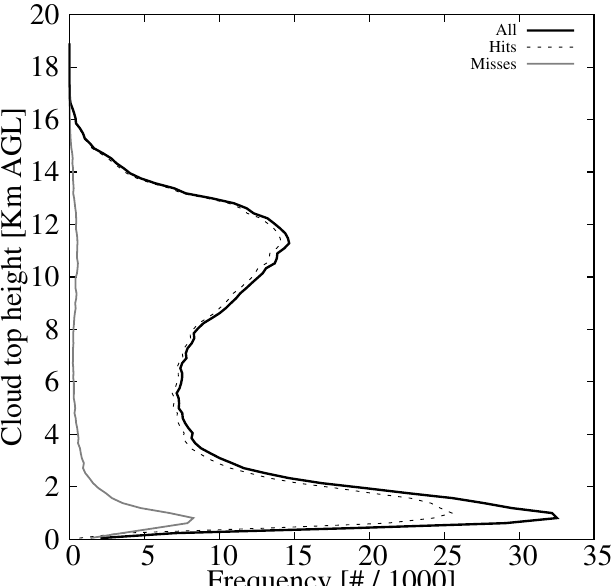
Figure 11. CALIPSO cloud top height histogram for all retrievals, (black line), cloud hits (black dashed line), and cloud misses (gray line).